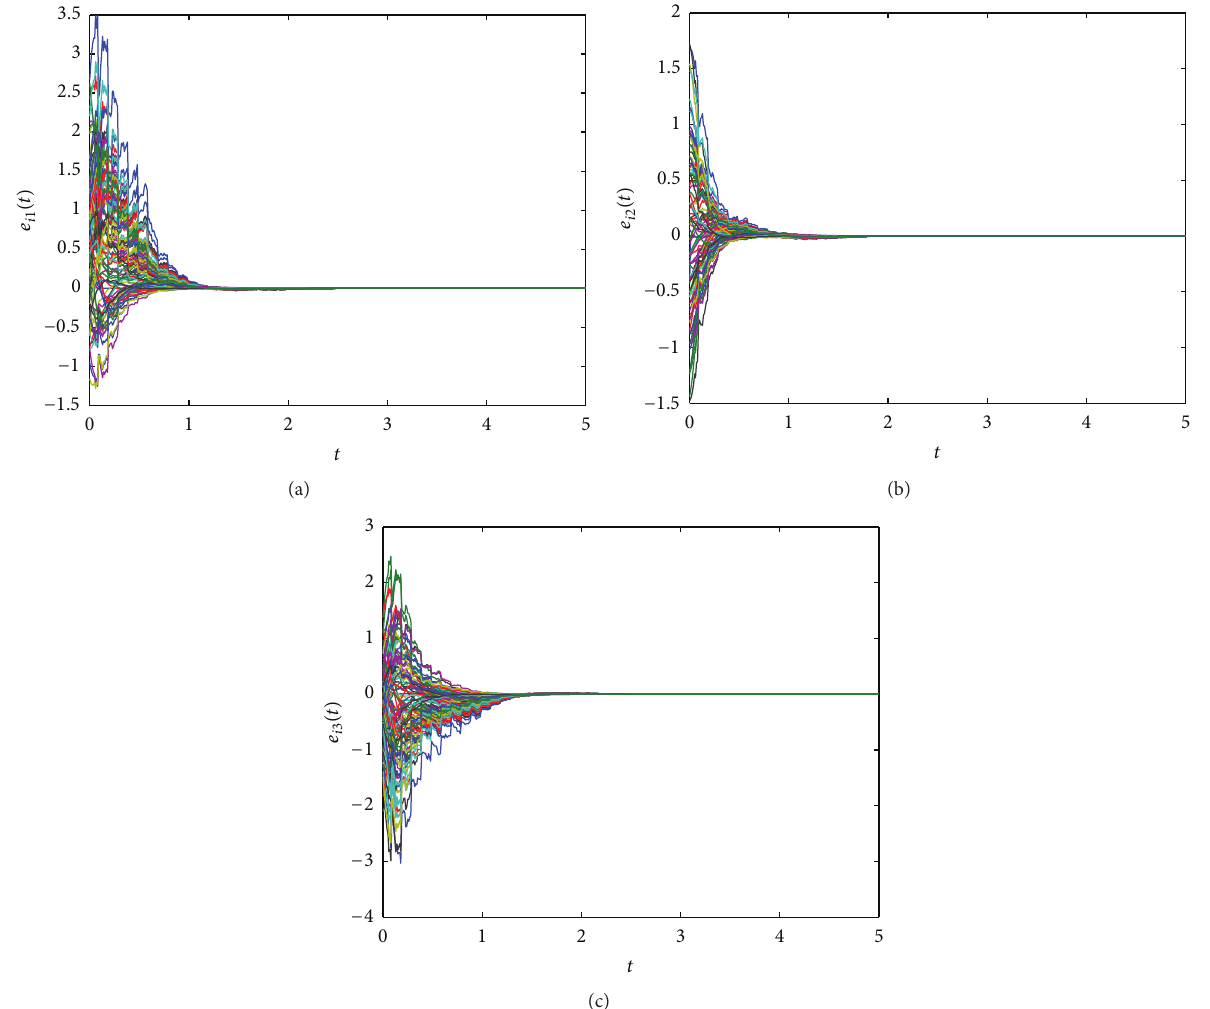
Figure 5: Error variables 𝑒 𝑖 (𝑡) = 𝑥 𝑖 (𝑡) − 𝑠(𝑡), 𝑖 = 1, 2, .. ., 100 of the coupled dynamical network with impulsive disturbances when |𝜇| > 1